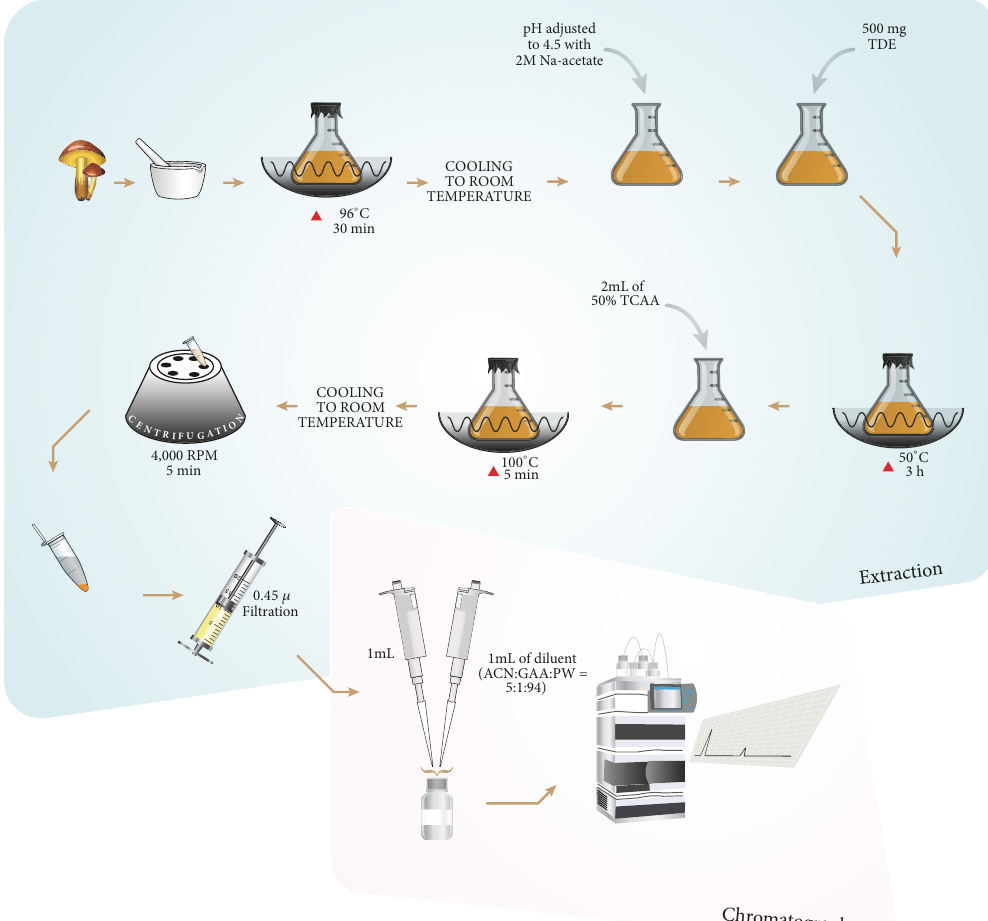
Figure 1: Schematic diagram of the mushrooms extraction